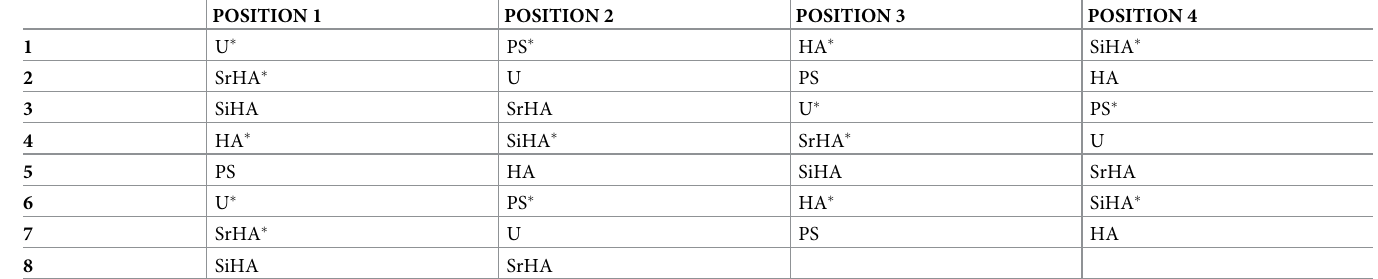
Table 1. Implant position and orientation within condyle defects. U, uncoated; PS, plasma sprayed HA; HA, electrochemical HA; SiHA, electrochemical SiHA; SrHA, electrochemical SrHA. SP � (700 μ m implant) orientated